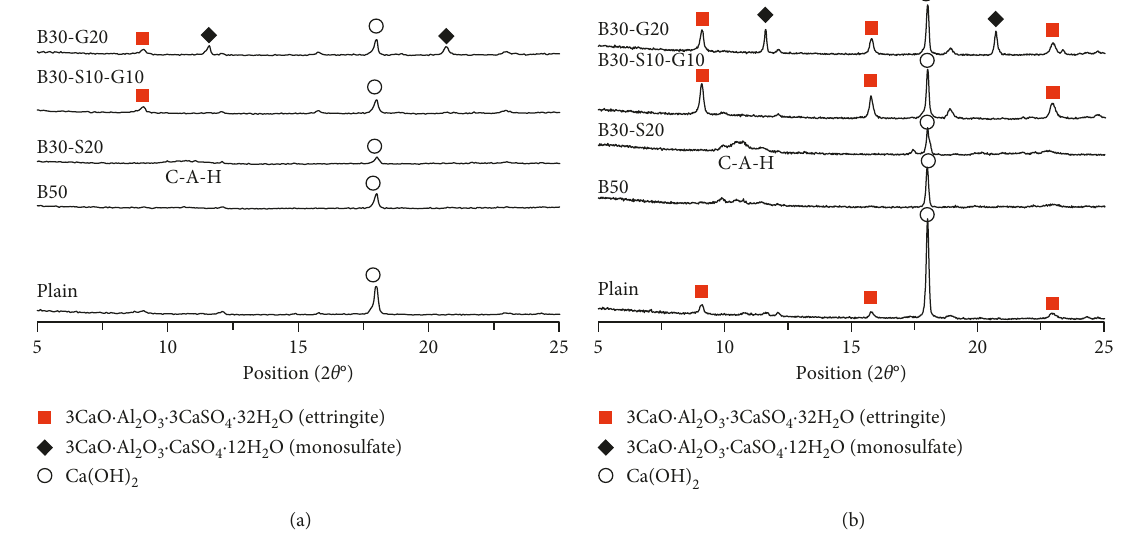
Figure 7: XRD spectra of hydrates at (a) 3 days and (b) 91